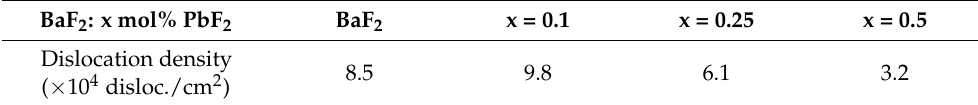
Table 1. Dislocation